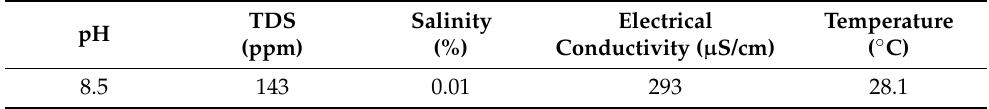
Table 2. Properties of sample water (river